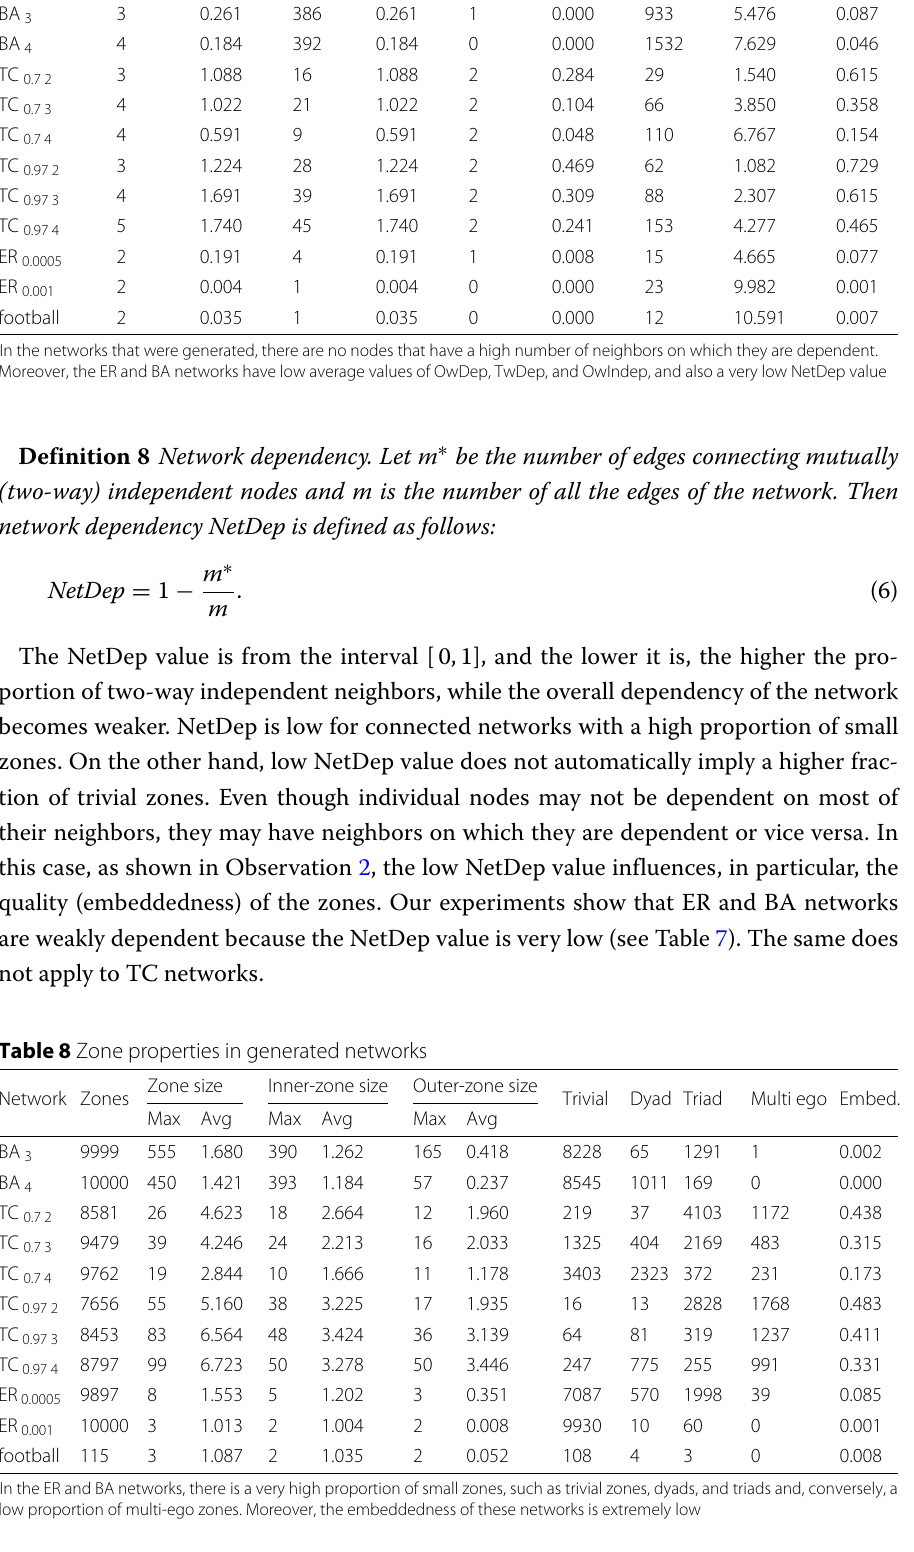
Table 7 Node dependencies and network dependency in generated networks OwDep Network